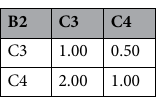
Table 5. Judgment matrix B2-Ci (i = 3–4).